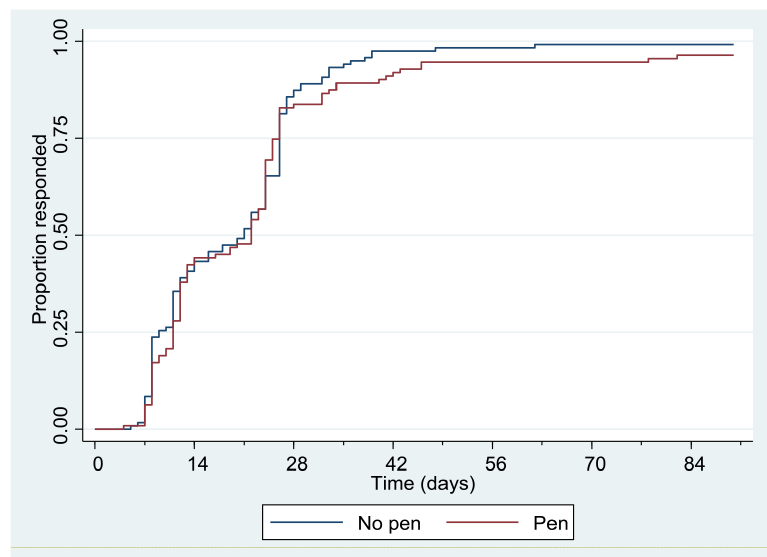
Figure 2. Kaplan–Meier survivor functions for time to return 3-month follow up questionnaire.